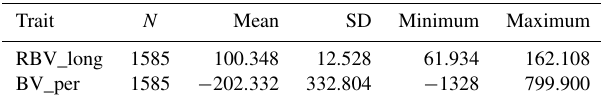
Table 7. Descriptive statistics for relative breeding value of longevity and BV of lactation persistency.